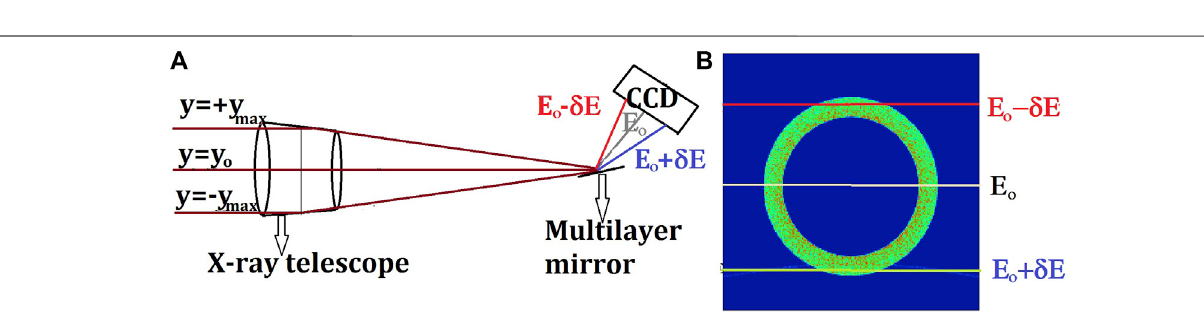
FIGURE 3 | Working principle of the Spectrograph. (A) X-ray from different portions of the telescope are incident at different angles on the multi-layer mirror which re fl ectsarangeofenergies. (B) Detectorviewwhenplacedat10 cmdefocusasshownin Figure1 .Verticalaxiscontainsthespectralinformationandthehorizontalaxis contains the spectral intensity information.